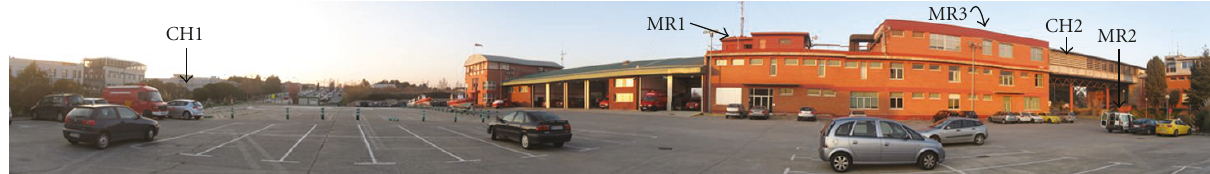
Figure 15: Five node mesh network trial in Bellaterra, Spain. MR1 is located at the roof of the red fire brigade building. CH1 and MR2 are located on opposite sides of the parking lot in front of the building. CH2 and MR3 are on the other side of the